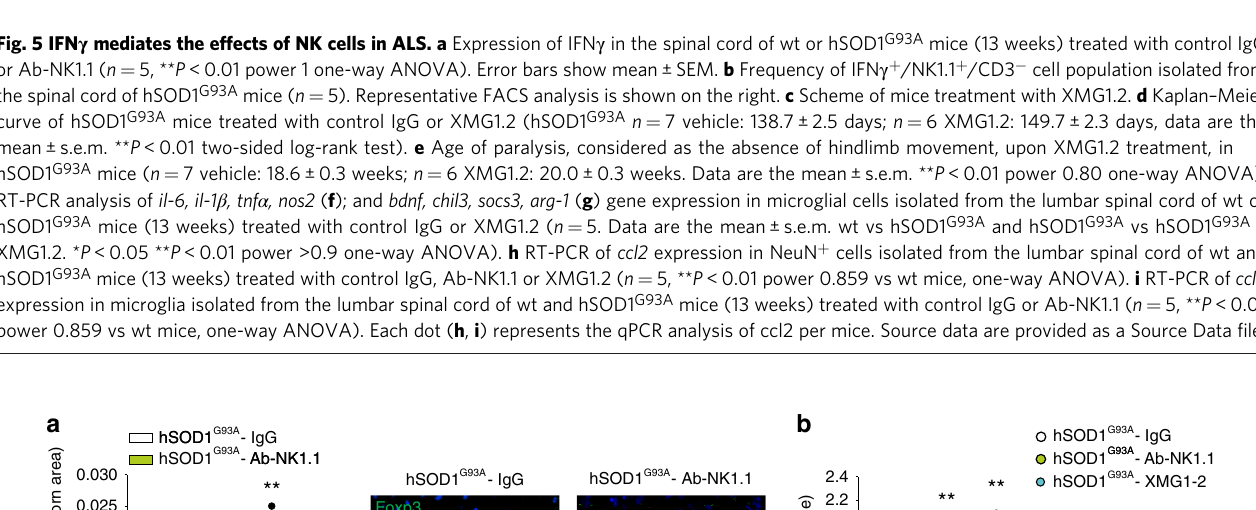
adherent fraction and analysed by FACS. Cell viability of spinal cord primary culture was determined by MTT assay or by staining dead cells. Results are expressed as percentage of cell survival, taking as 100% the cells not incubated with NK cells.